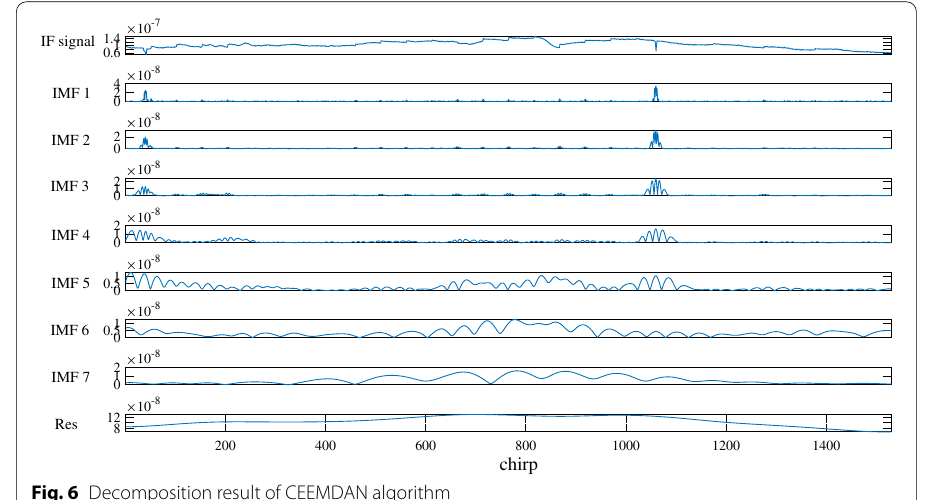
Fig. 6 Decomposition result of CEEMDAN algorithm